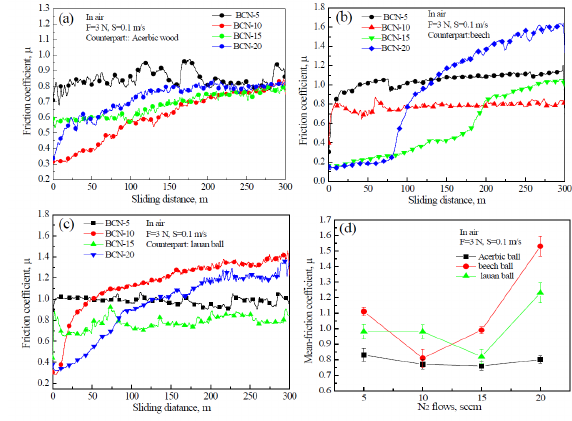
Figure 5: Friction behavior and mean friction coeflcient of BCN coat- ing as sliding against wood